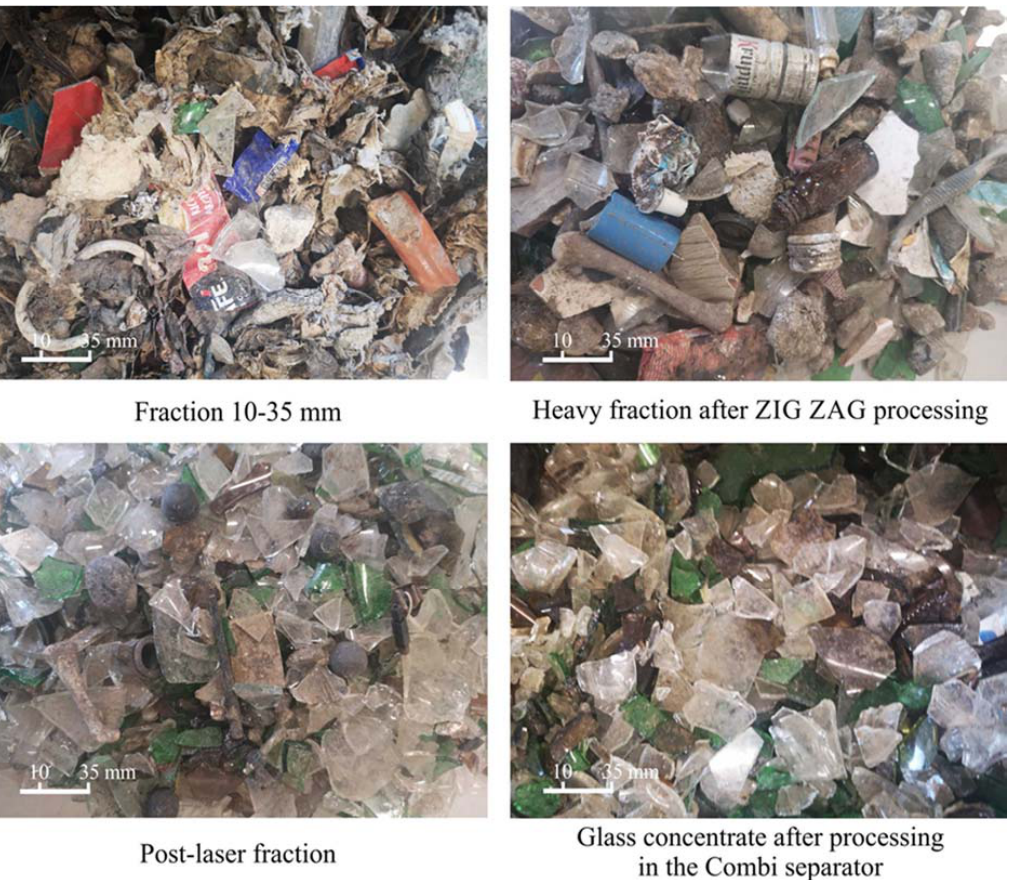
Figure 6. Fractions after successive stages of the process of recovering glass from stabilizers. Processing the stabilizer on the line yielded between 49.8% and 74.3% of the glass contained in it (68,4 ± 7,0% on average) for the samples from Marszów and between 38.3% and 72.1% (58,4 ± 14,2% on average) in the case of samples collected from other MBT installations. Concentrates contained no paper, plastics or metals. Organic matter was found in only two samples from Marszów (Figure 7).